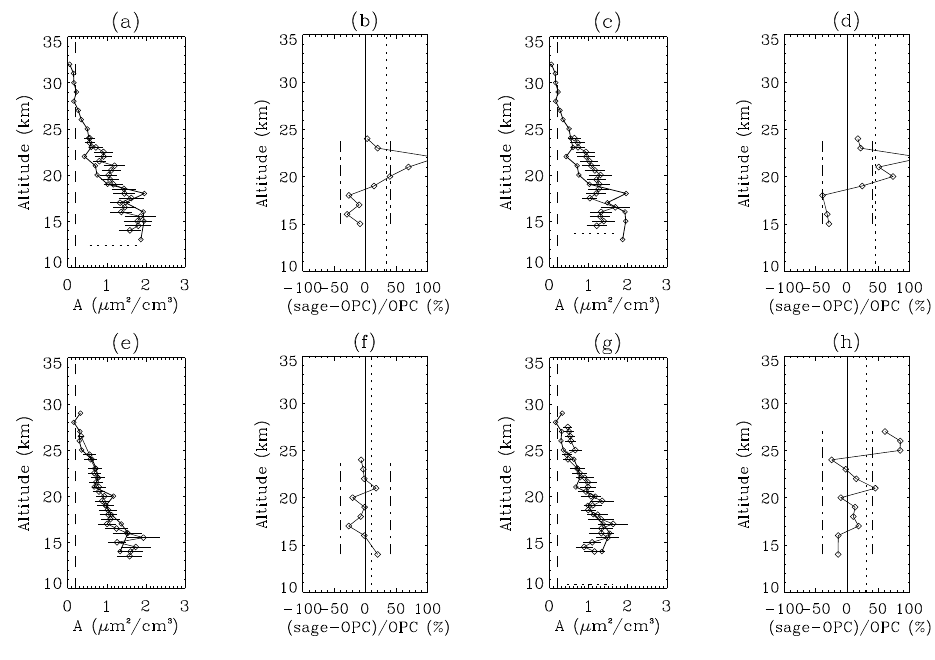
Fig. 15. As Fig. 14 but for surface area density as derived from the retrieved Optimal Estimation size distribution parameters.